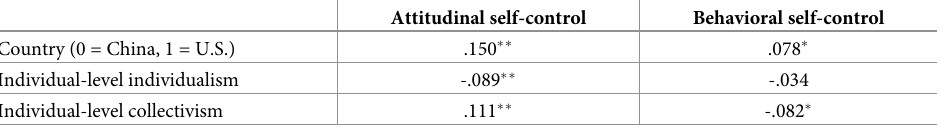
Table 2. Bivariate correlation between individual-level individualism and collectivism with attitudinal and behav- ioral self-control.